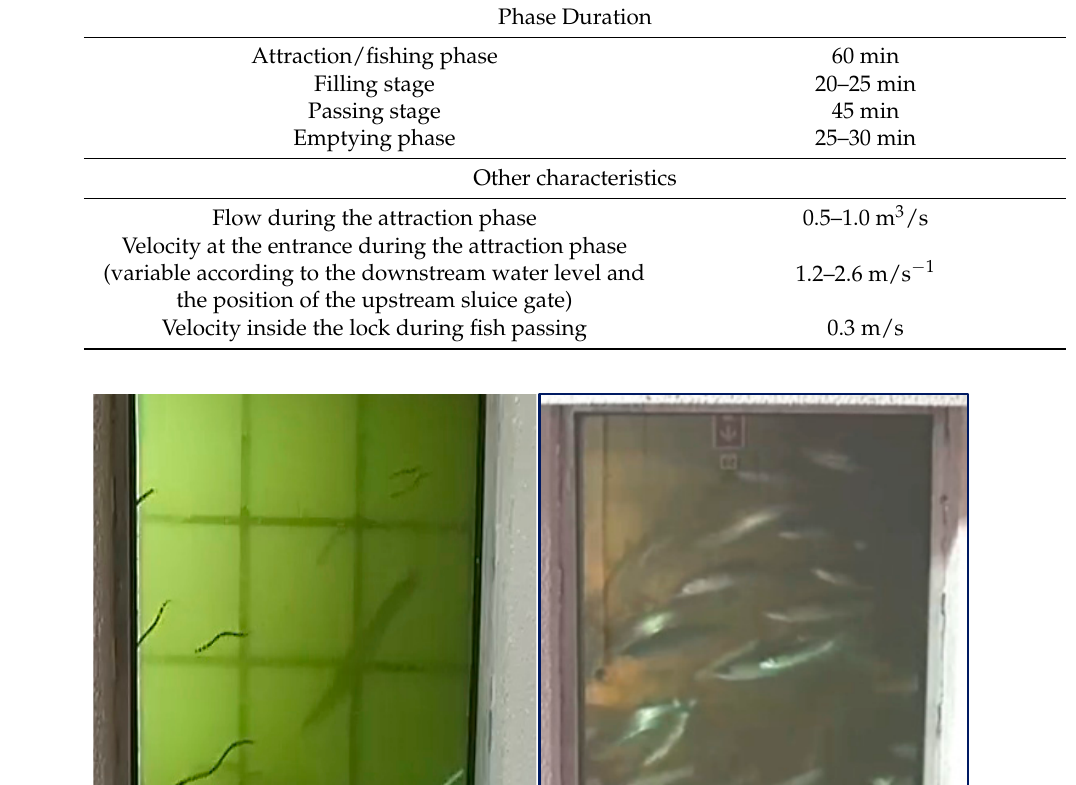
Table 2. Operational details for the fish lock of the Crestuma-Lever dam (Data provided by the dam owner, EDP).